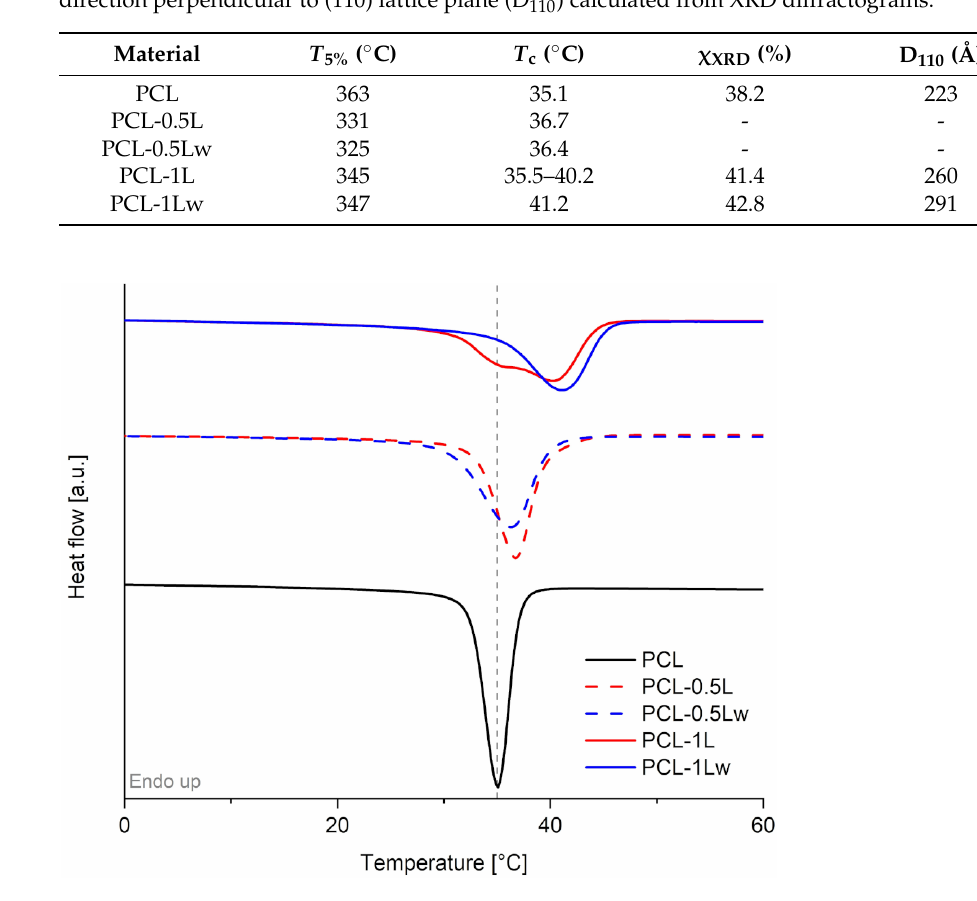
Figure 3. DSC cooling scan of neat and reacted